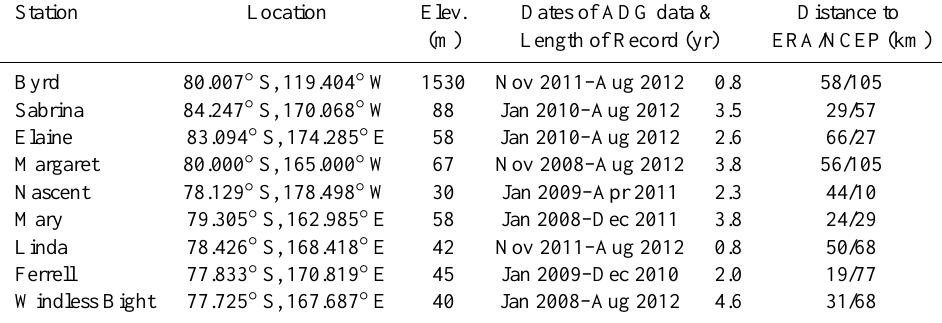
Linda Ferrell 77.833 ◦ S, 170.819 ◦ E Windless